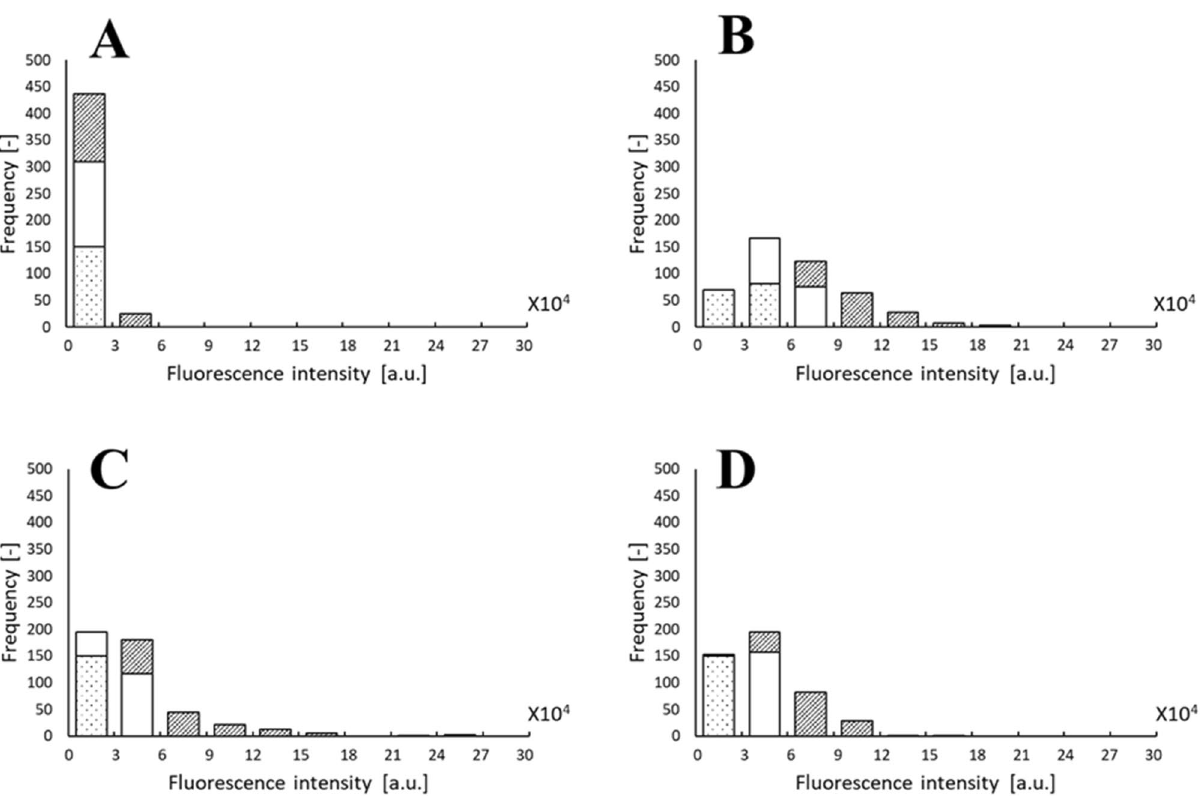
Figure 2. Frequency distributions of fluorescent intensities of all peptides such as 150 positive (slashed bar), 150 negative (dotted bar) and others (blank bar). ( A ) 4-mer, ( B ) 5-mer, ( C ) 6-mer, ( D )